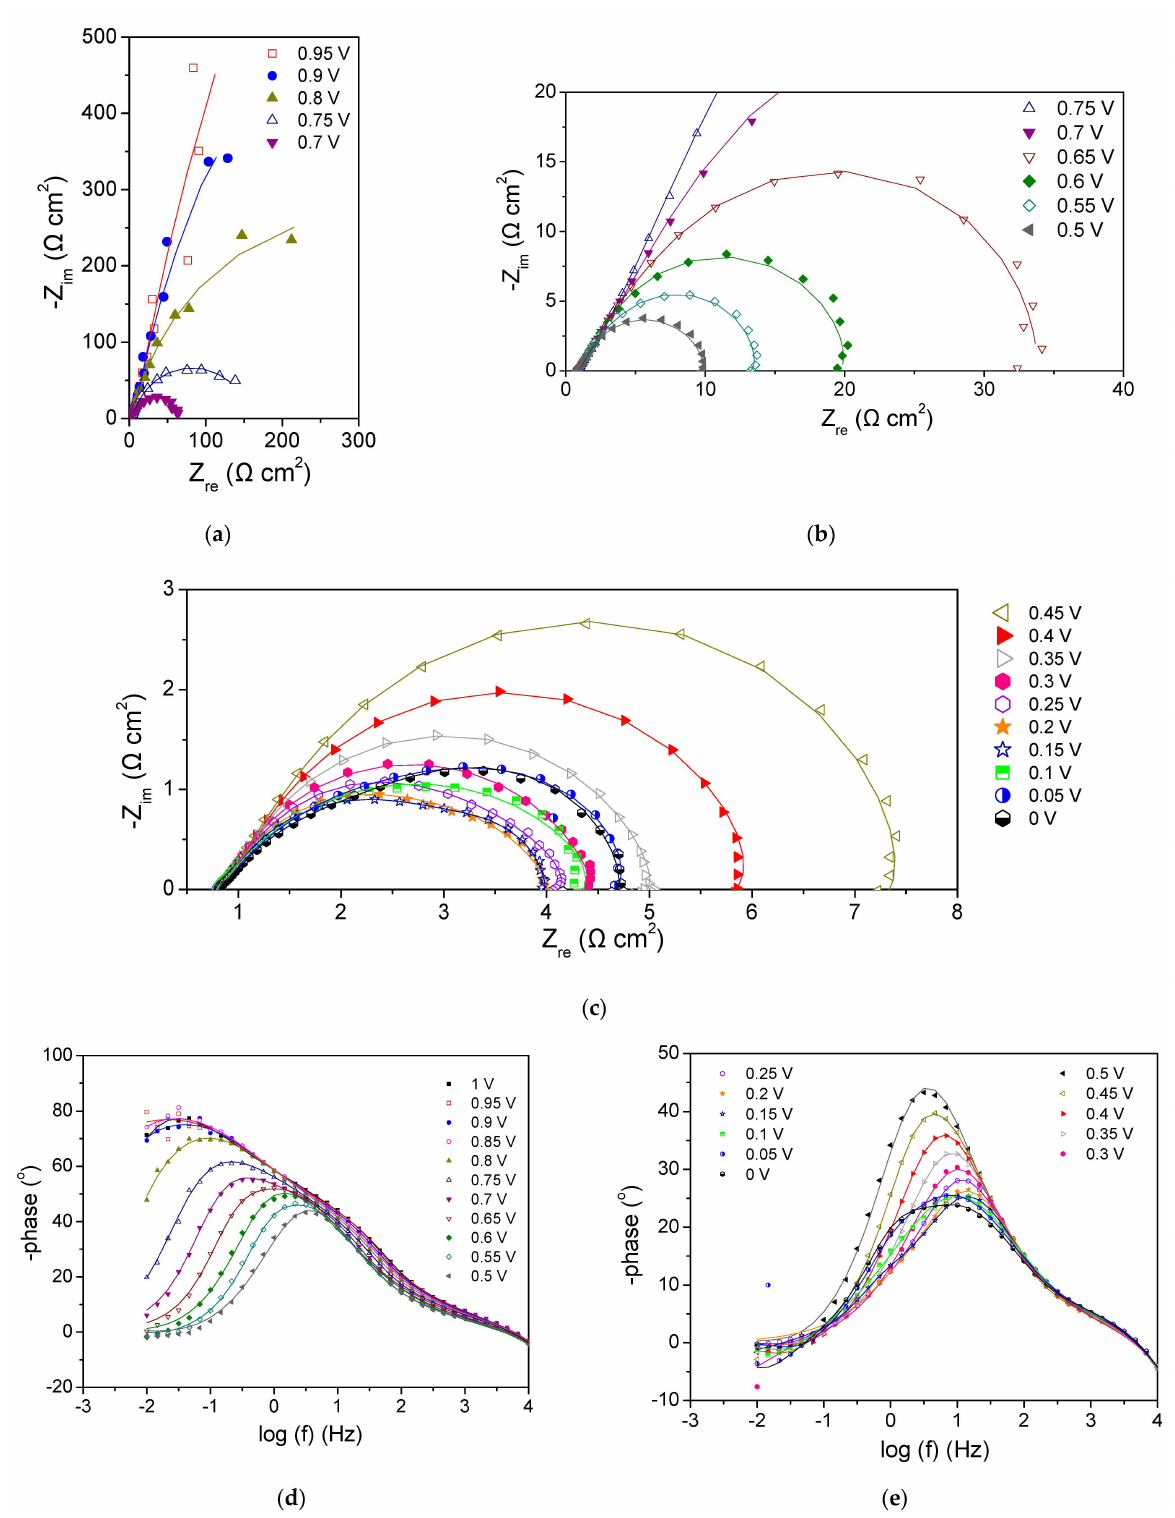
Figure 5. Effect of cell potential U fc on the EIS characteristics of the PEMFC with the 22Pd—7Zn cathode electrode, presented in the form of Nyquist plots ( a – c ) and negative phase angle vs. log(frequency f ) Bode plots ( d , e ); Flow rates: F anode (100% H 2 ) = F cathode (synthetic air) = 100 cm 3 min − 1 ; geometric electrode surface area, A elec = 5.29 cm 2